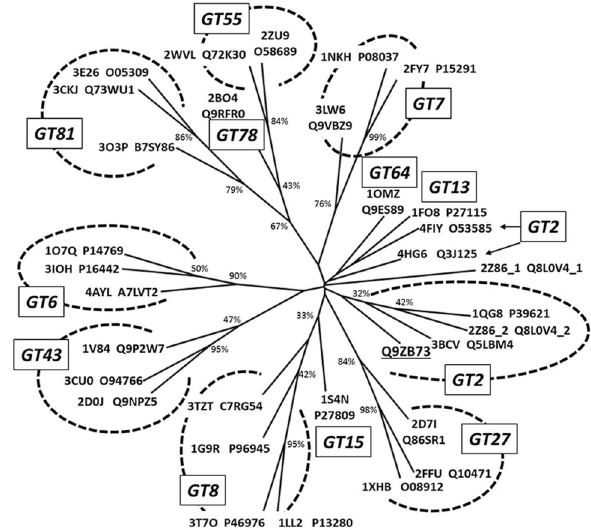
Figure 4. Phylogenetic tree of GT-A proteins with known 3D structure. The tree was generated from the curated GT domain multiple sequence alignment shown in Figure